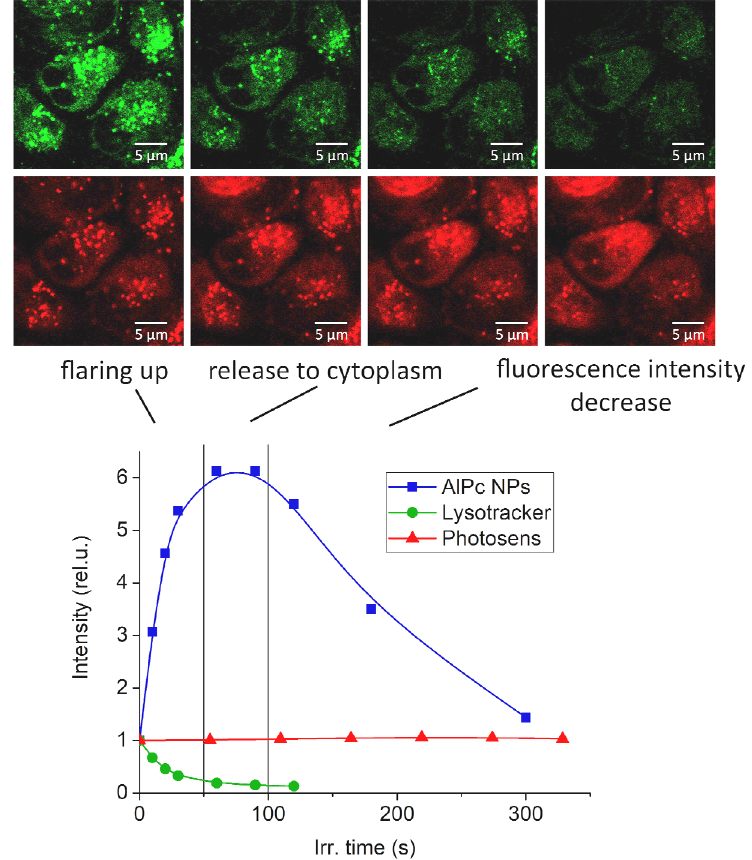
Figure 4. Fluorescence images of HeLa cells (top row) after 24 h of incubation with AlPc NPs. Top row: green—Lysotracker fluorescence, red—AlPc NP fluorescence, from left to right—destruction of lysosomes by irradiation with a 633 nm laser. Bottom: fluorescence-intensity dynamics during laser irradiation.